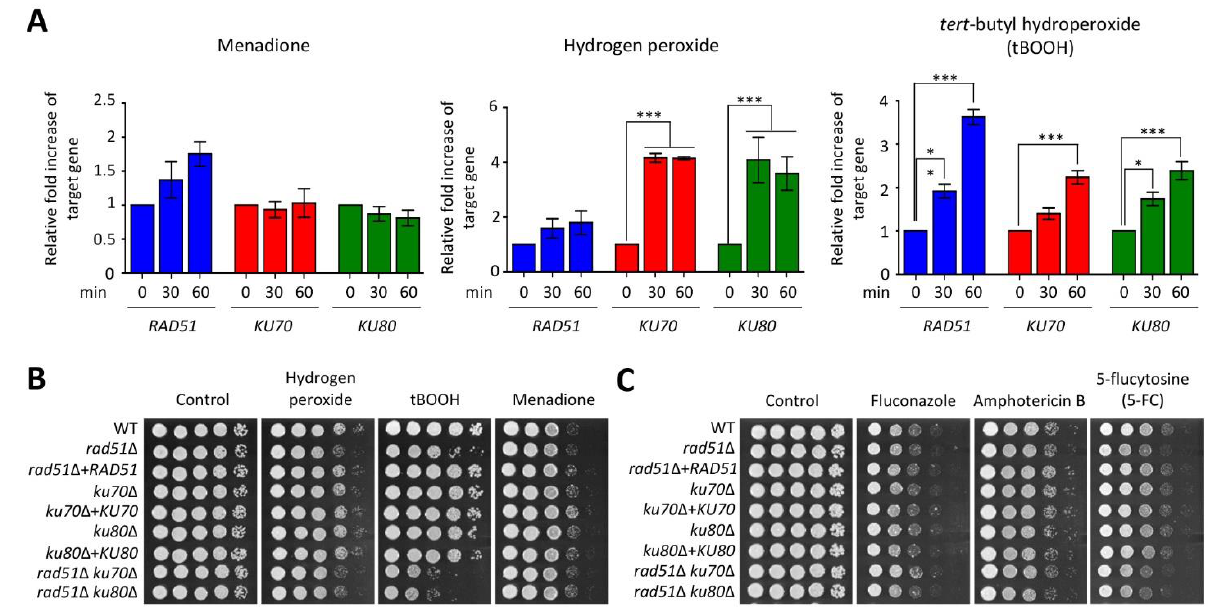
Figure 3. Functional roles of homologous recombination (HR) and non-homologous end joining (NHEJ) pathways in oxidative stress and antifungal drug resistance. ( A ) Expression levels of KU70 , KU80 , and RAD51 genes in response to oxidative stress. Real-time quantitative PCR (qRT-PCR) analysis using cDNA synthesized from total RNA isolated from the wild-type (WT) strain treated with oxidative stress agents (hydrogen peroxide: 2.5 mM; tBOOH: 1 mM; menadione: 0.02 mM) for 1 h. Three independent biological experiments with duplicate technical replicates were performed. Statistical significance of difference was determined by ANOVA with Bonferroni’s test. Error bars indicate standard errors of means (* p < 0.05 and *** p < 0.001). ( B , C ) C. neoformans strains were cultured in liquid YPD medium 16 h at 30 °C. The grown cells were serially diluted (1 to 10 4 ) and then spotted on a YPD plate containing the indicated concentration of oxidative stress agents (hydrogen peroxide: 2.5 mM; tBOOH: 0.9 mM; menadione: 0.02 mM) or antifungal drugs (fluconazole: 16 μ g/mL; amphotericin B: 1 μ g/mL; 5-flucytosine: 400 μ g/mL). Strains were further incubated for 1 to 3 days at 30 °C and photographed daily.